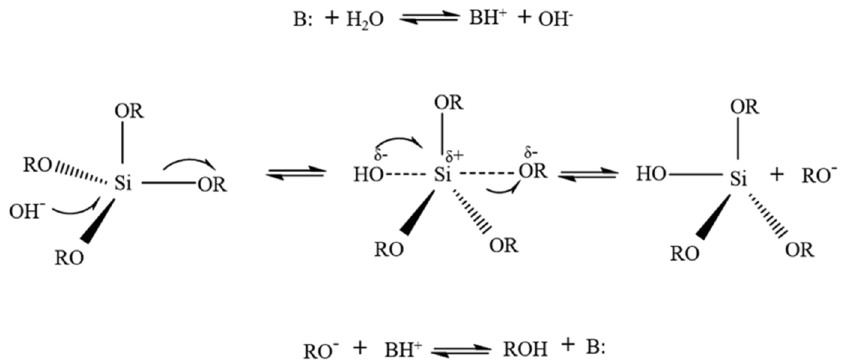
Figure 2: Mechanism of hydrolysis of TEOS precursors in base - catalyzed reactions [ 55 ] ; Copyright: 2021 with permission from Elsevier